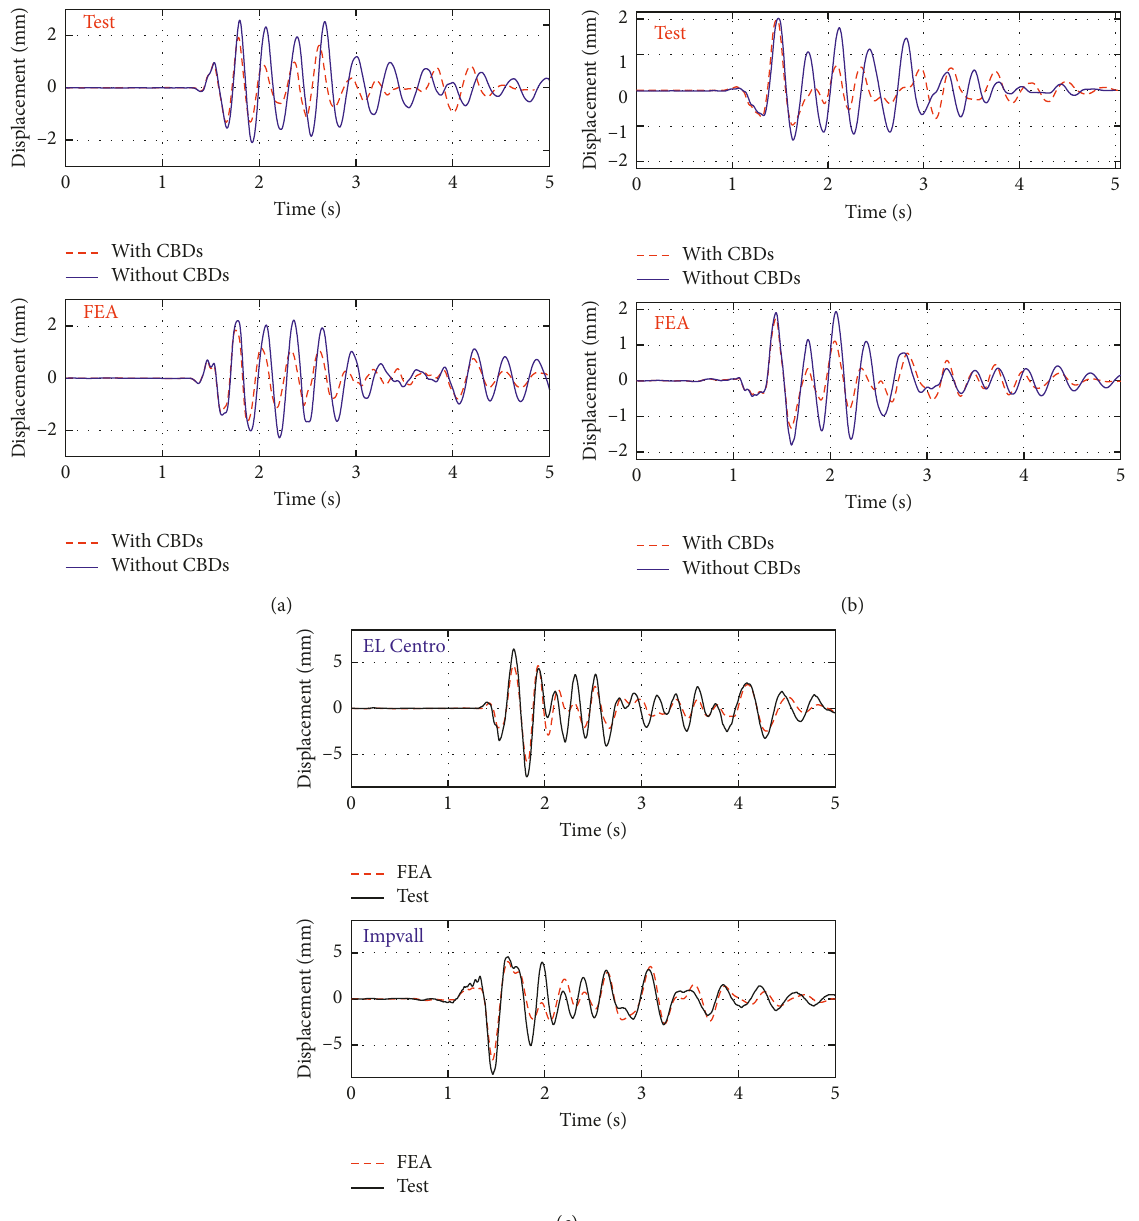
Figure 17: Comparison of responses between test and FEA models. Time-history response of story drift under (a) El Centro seismic excitation and (b) Impvall seismic excitation. (c) The displacement response of CBD3 under El Centro and Impvall seismic